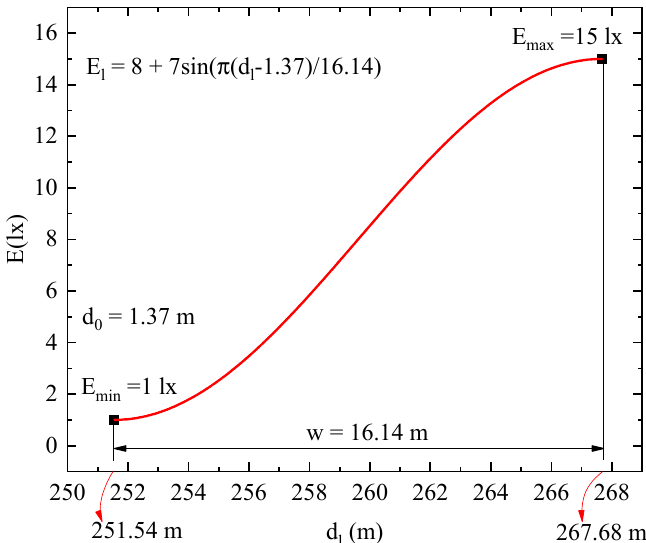
Figure 5. Example of applying sine model at distances from d l = 151.54 m to 267.68 m in the longitudinal direction of a road. The E min and E max corresponding to the two distances are 1 lx and 15 lx, respectively, and w = 16.14 m. All known values, E min , E max , w, d l , and E l , are used in Equation (1), and d 0 is calculated to be 1.37 m.